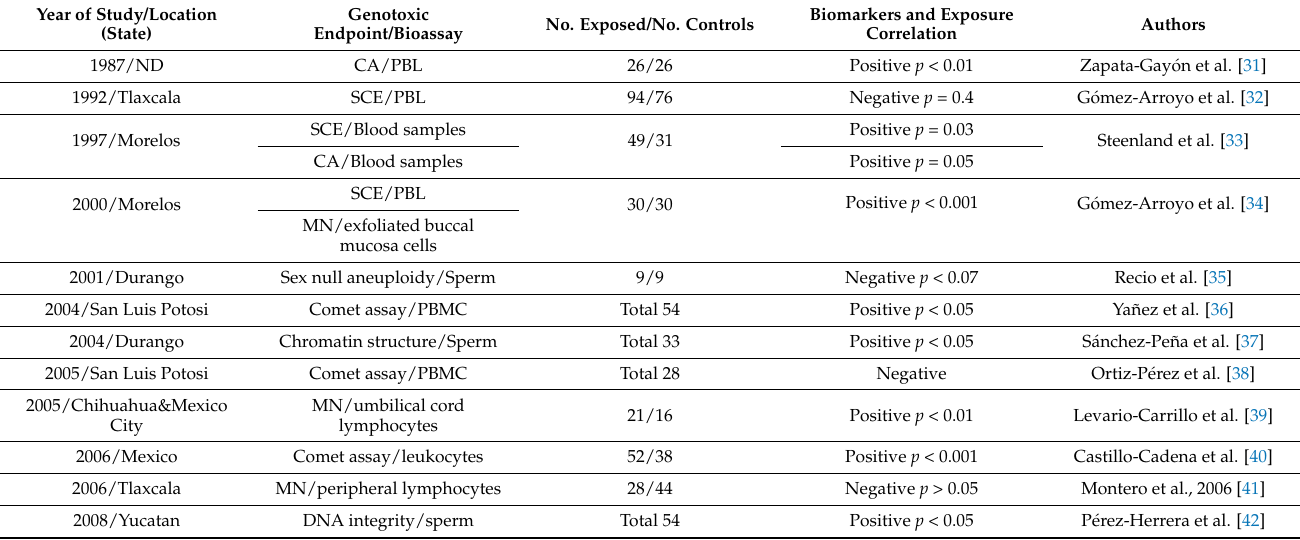
Table 1. Studies developed in Mexico on genotoxicity biomarkers in populations exposed to